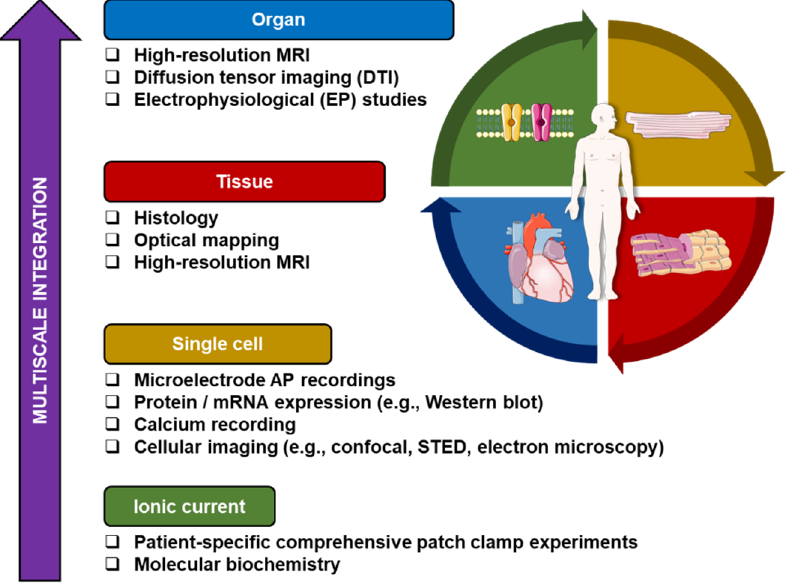
Figure 6. A schematic illustration summarizing multiscale integration of patient-specific data. The “bottom-up” approach starts from the ionic current/molecular level up to the organ level. At each scale, the acquired data can be utilized as an input for computational modeling. Ultimately, a personalized 3-dimensional computational model can be developed and used for patient-specific arrhythmia research. (MRI = Magnetic Resonance Imaging; mRNA = messenger Ribonucleic acid; STED = Stimulated Emission Depletion).